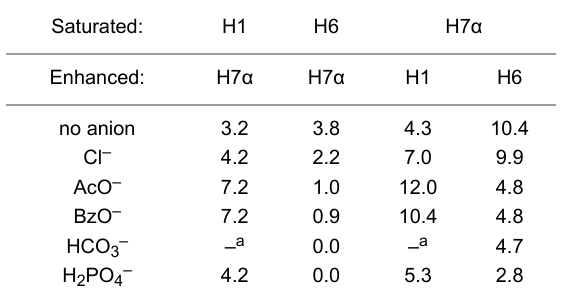
Table 3: Selected NOE enhancements for 1 in the absence and in the presence of different anions (in %). Saturated: